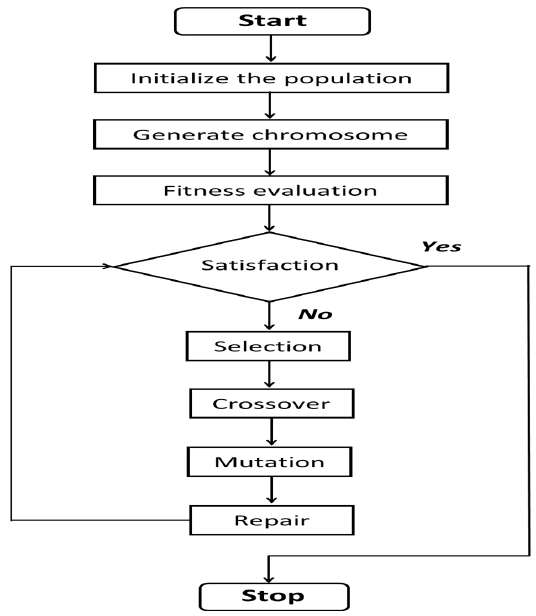
Figure 5. Flow chart on genetic algorithm in this study.